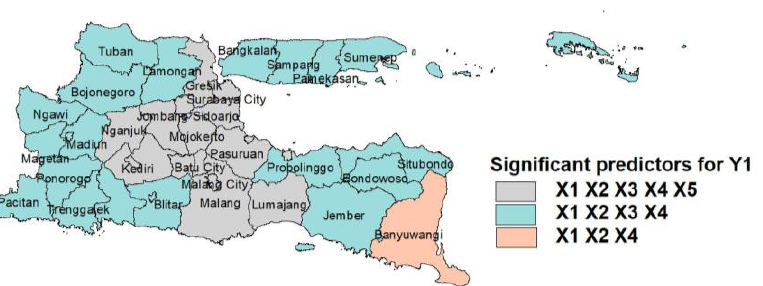
Figure 5. Regional group based on factors that influence the number of infant deaths in East Java in 2019.